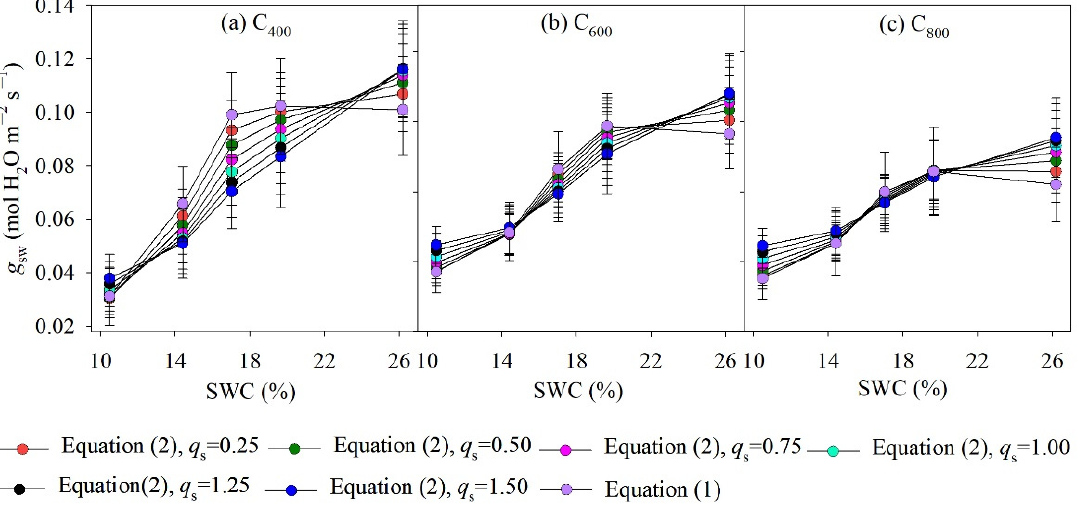
Figure 3. The estimated leaf stomatal conductance ( g sw, mol H 2 O · m − 2 · s − 1 ) in Platycladus orientalis saplings under different soil water contents (SWC) and CO 2 concentrations ( C a ) conditions, based on different models (Equations (1) and (2)). C 400 , C 600 , and C 800 are C a of 400 ( a ), 600 ( b ), and 800 µ mol · mol − 1 ( c ). Tunable parameter q s is a measure of the nonlinearity of the effects of soil water stress on the stomatal limiting mechanisms. Data represent mean values ± SD.